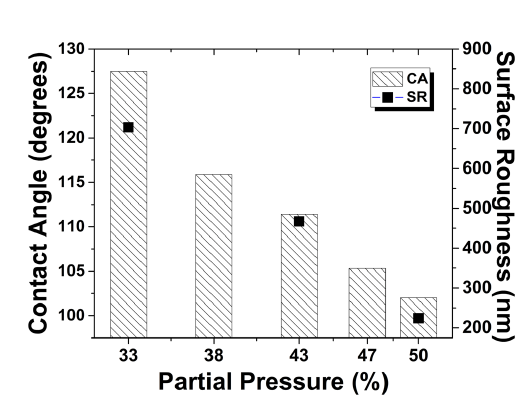
Figure 7. Wettability and surface roughness of AZO coatings prepared at different argon partial